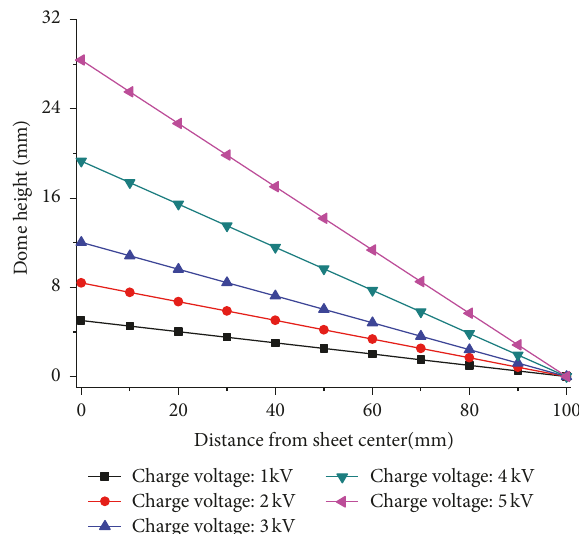
Figure 8: Height profile of the deformed workpieces after EHF.